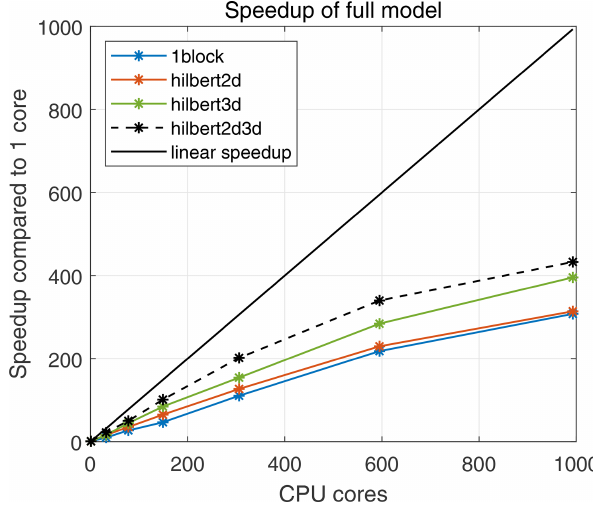
Figure 7. Speedup compared to one core for the full model. Dif- ferent partitions are shown in color (1block, hilbert2d, hilbert3d,